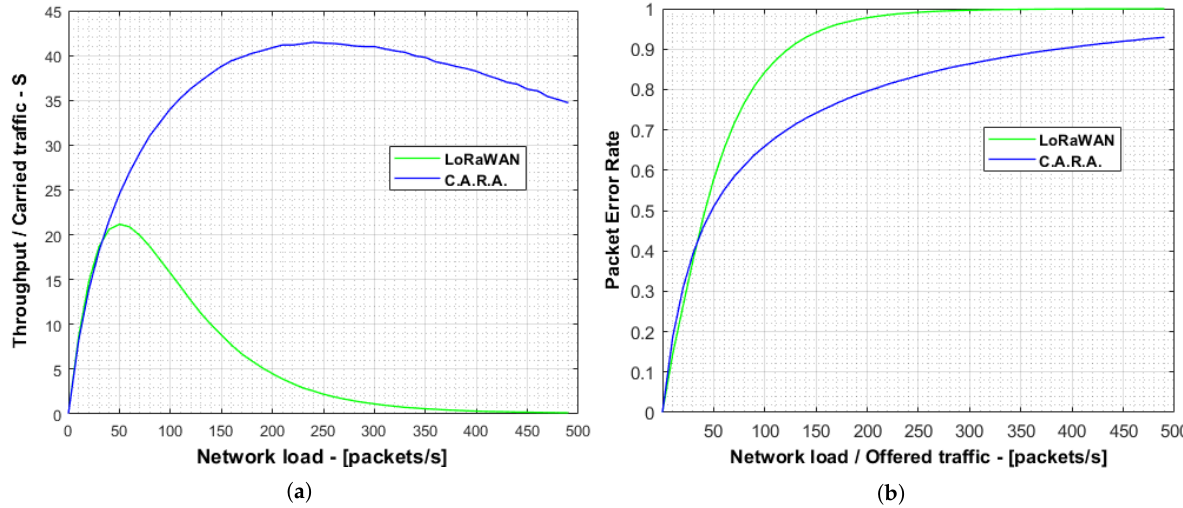
Figure 10. Comparison of the throughput and PER for 50,000 devices between a standard LoRaWAN network and using CARA. ( a ) System throughput and ( b ) Packet Error Rate.